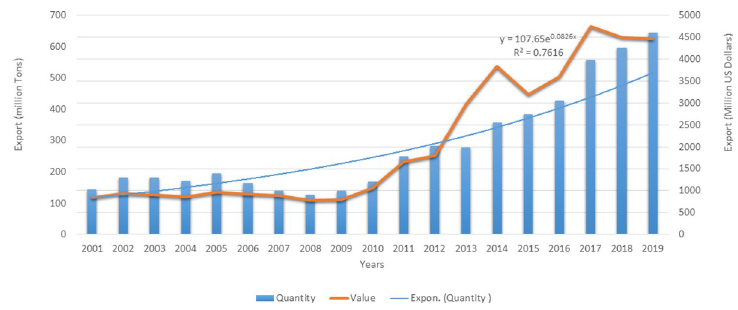
Fig 1. Performance of Indian crustacean export to the world